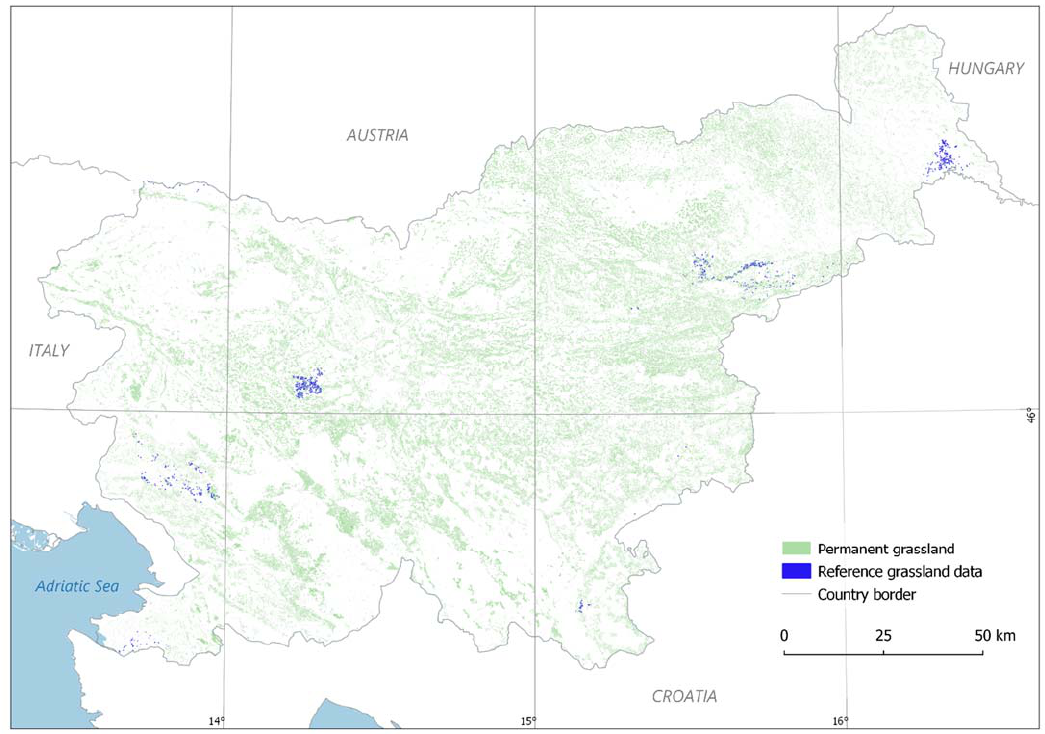
Figure 2. Study area (entire Slovenia) with the permanent grassland cover and reference grassland